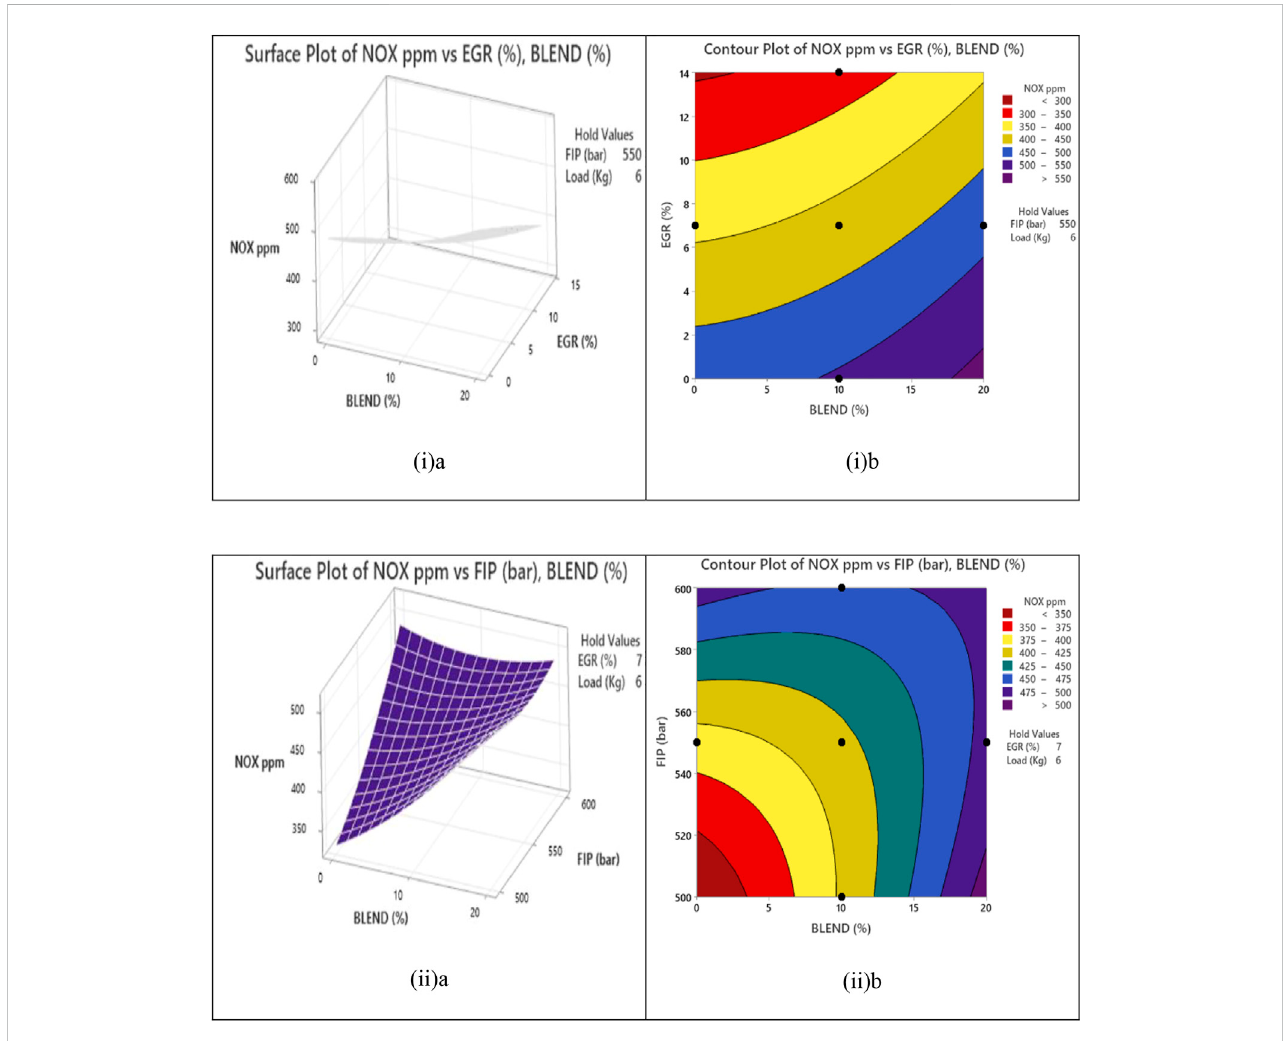
FIGURE 9 Effect of input factors on NOx